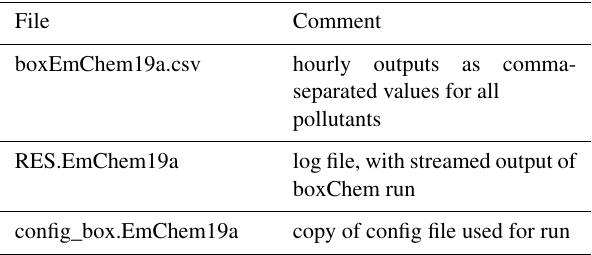
Table 2. Outputs a for a boxChem run achieved via “do.testChems EmChem19a”.